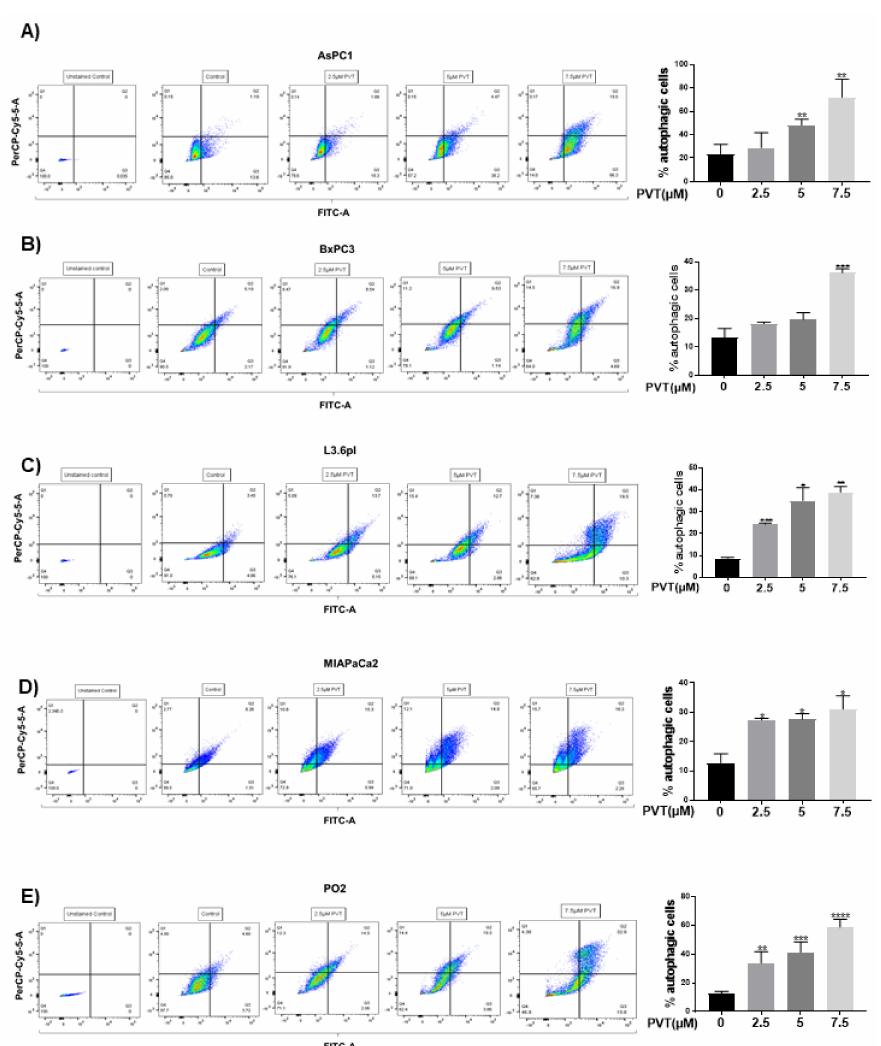
Figure 1. PVT treatment increases autophagy in PDAC cells. Autophagic effects of PVT in ( A ) AsPC1, ( B ) BxPC3, ( C ) L3.6pl, ( D ) MIAPaCa2, and ( E ) PO2 cells were evaluated by acridine orange assay